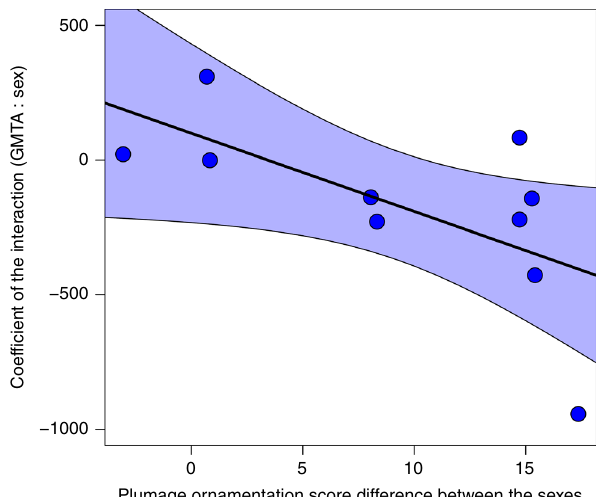
Fig. 3 The relationship between plumage ornamentation differences between male and female birds. Plumage ornamentation score differences between male and female birds is calculated as (male ornamentation − female ornamentation ). We illustrate the interaction in the models that tested the effects of global mean temperature anomalies (GMTA) and bird sex on the area of moulted feathers in the post-juvenile moult in relation to plumage ornamentation score differences among sexual-dichromatic bird species tested in the study ( n = 10). In species with a larger difference in plumage ornamentation between the sexes, the response of females to GMTA was high compared to that of males, as shown here by their overall lower coef fi cients of the GMTA and sex interaction, with male relative to female values. The plumage ornamentation score is provided by Dale et al. 40 . The method used for quantifying plumage colouration for male and female of each species includes red, green and blue (RGB) measurements in three dorsal (nape, crown, forehead) and three ventral (throat, upper breast, lower breast) body patches. For each plumage patch, RGB values for both sexes in all the ten species were